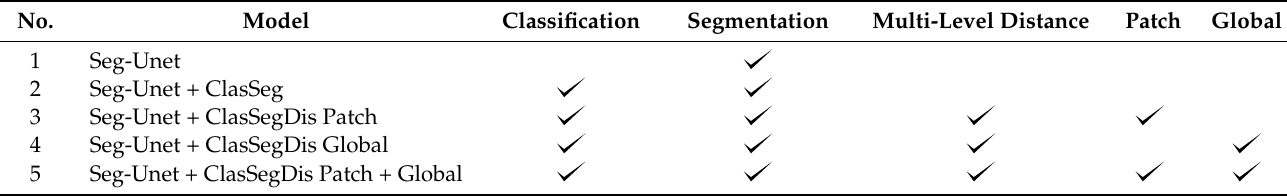
Ablation study to specifically test the effects of the three branches with global, patch-based, and combination